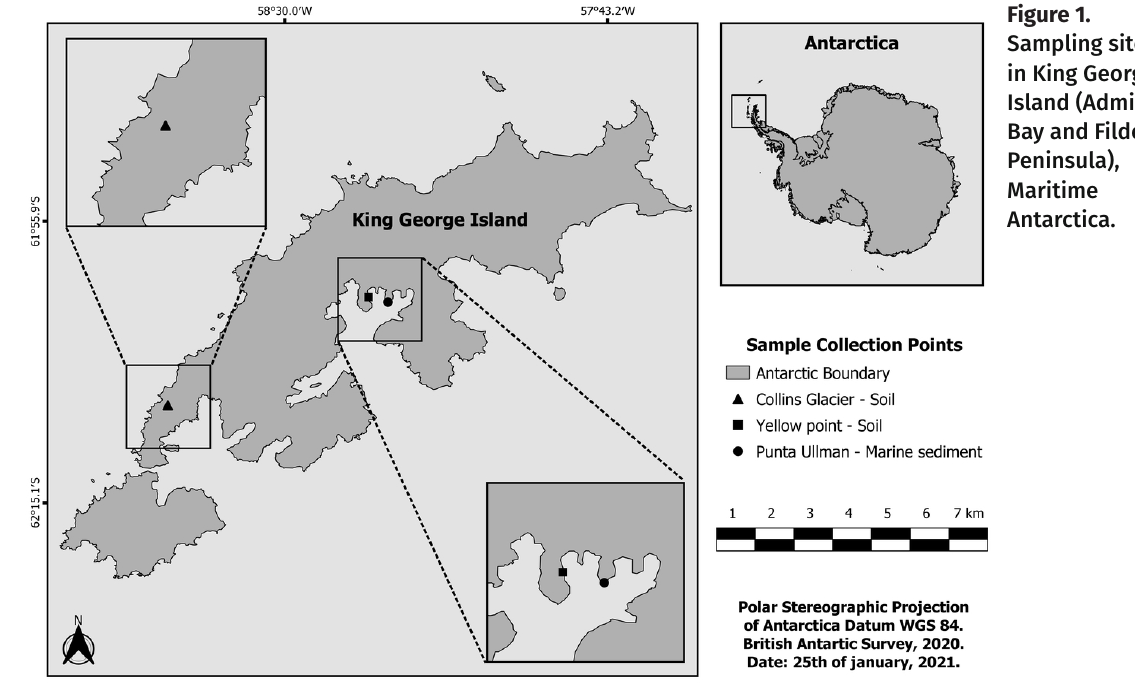
Figure 1. Sampling